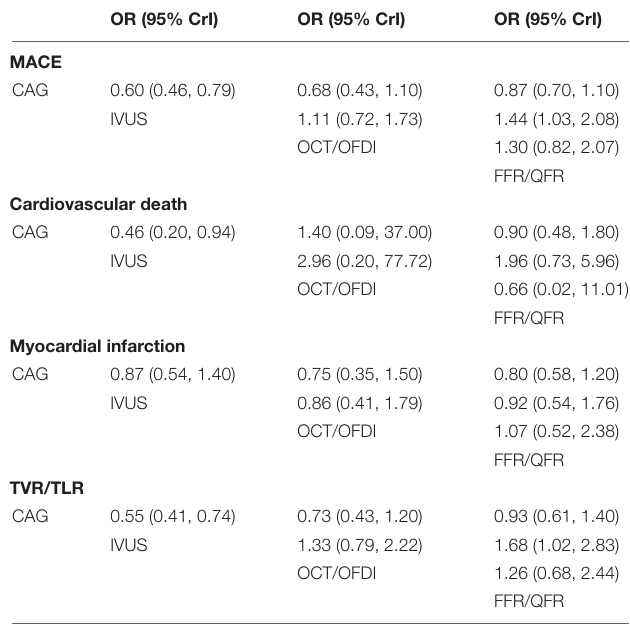
FIGURE 2 | Comparisons of primary outcomes among guidance modalities included in the network meta-analysis. CAG, coronary angiography; FFR, fractional flow reserve; IVUS, intravascular ultrasound; OCT, optical coherence tomography; OFDI, optical frequency domain imaging; QFR, quantitative flow ratio. (A) Major adverse cardiovascular events. (B) Cardiovascular death. (C) Myocardial infarction. (D) target vessel revascularization/target lesion revascularization.